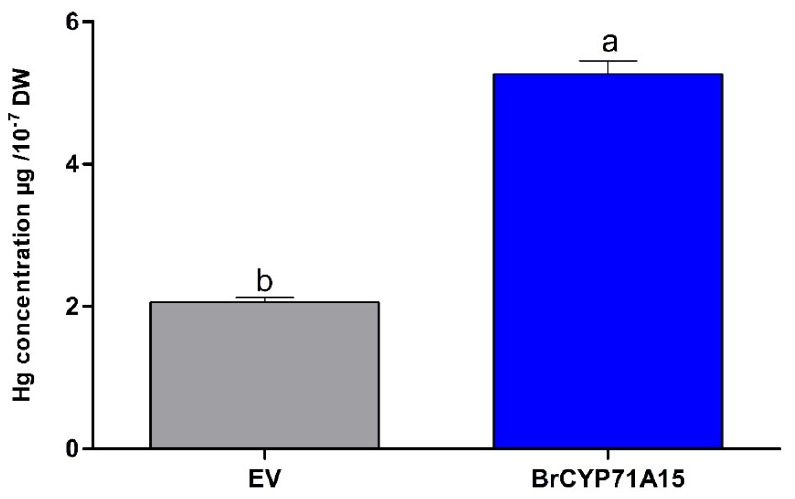
Figure 7. Hg concentration in yeast cells. Yeast strains expressing EV and BrCYP71A15 were grown at 30 °C for 2 d. The cells were collected in liquid SC with 100 mM Hg and the OD600 values were measured using an atomic absorption spectrometer. Error bars indicate ± SD of three independent experiments. Letters above the error bar represent significant differences at p > 0.005.